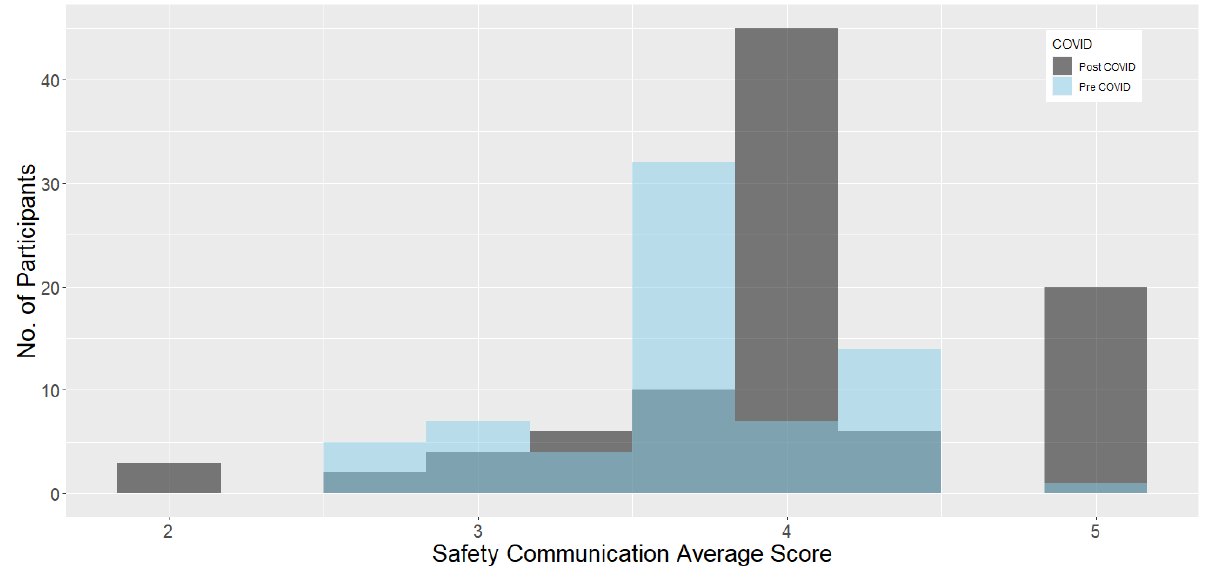
Figure 4. Safety Communication Average Scores by Participants ( n = 166).